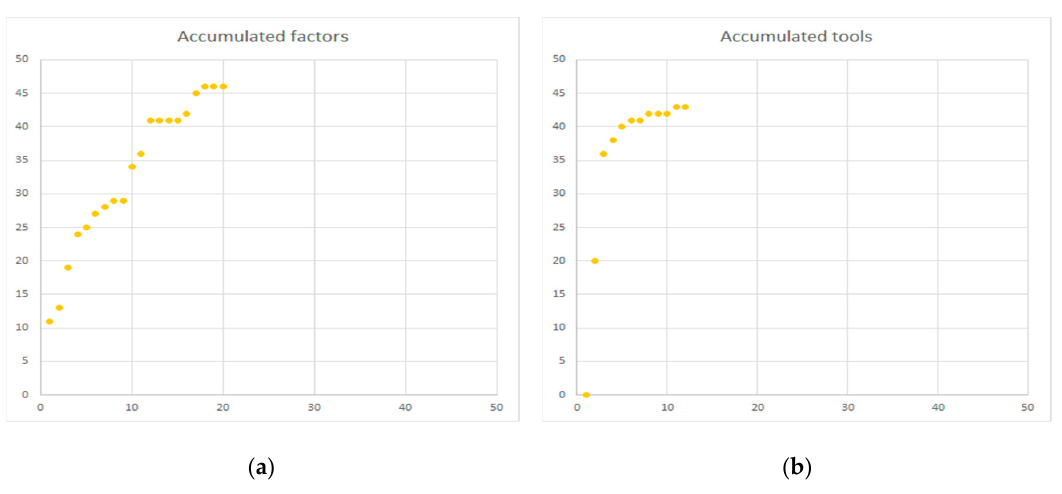
Figure 6. Log of data saturation: ( a ) Number of accumulated progression factors plotted against number of energy community (EC) reviews on the left; ( b ) number of accumulated UBEM tools plotted against number of UBEM reviews on the